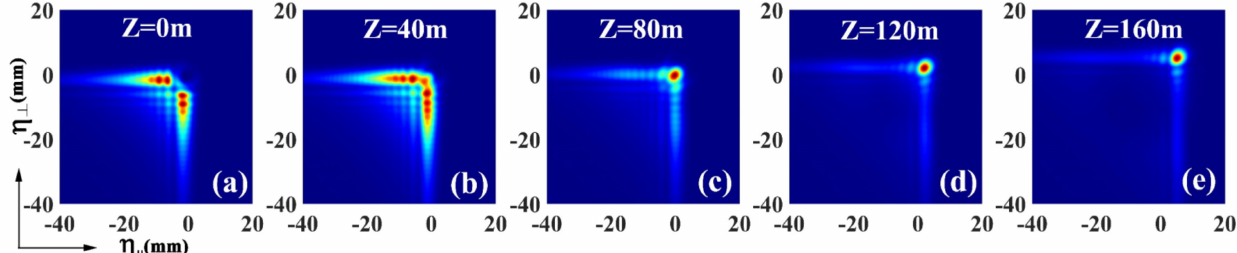
Figure 2. Density plots of the intensity distributions of a PCAB at the different propagation distances ( a ) Z = 0 m, ( b ) Z = 40 m, ( c ) Z = 80 m, ( d ) Z = 120 m, and ( e ) Z = 160 m during propagation. The beam is obstructed by an opaque obstacle in the source plane. The source coherence width is given by δ 0 = 1